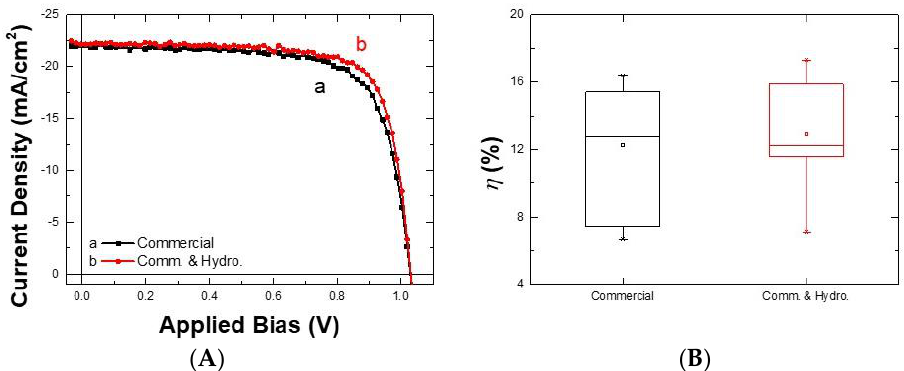
Figure 5. ( A ) J-V curves for PSCs with using the commercial PbI 2 (a, black trace) and commercial PbI 2 with an additional hydrothermal process (b, red trace). ( B ) average and deviation of the photoconversion efficiency of PSCs with the two different PbI 2 . Table 3. Photovoltaic performances of MAPbI 3 perovskite solar cells (PSCs).